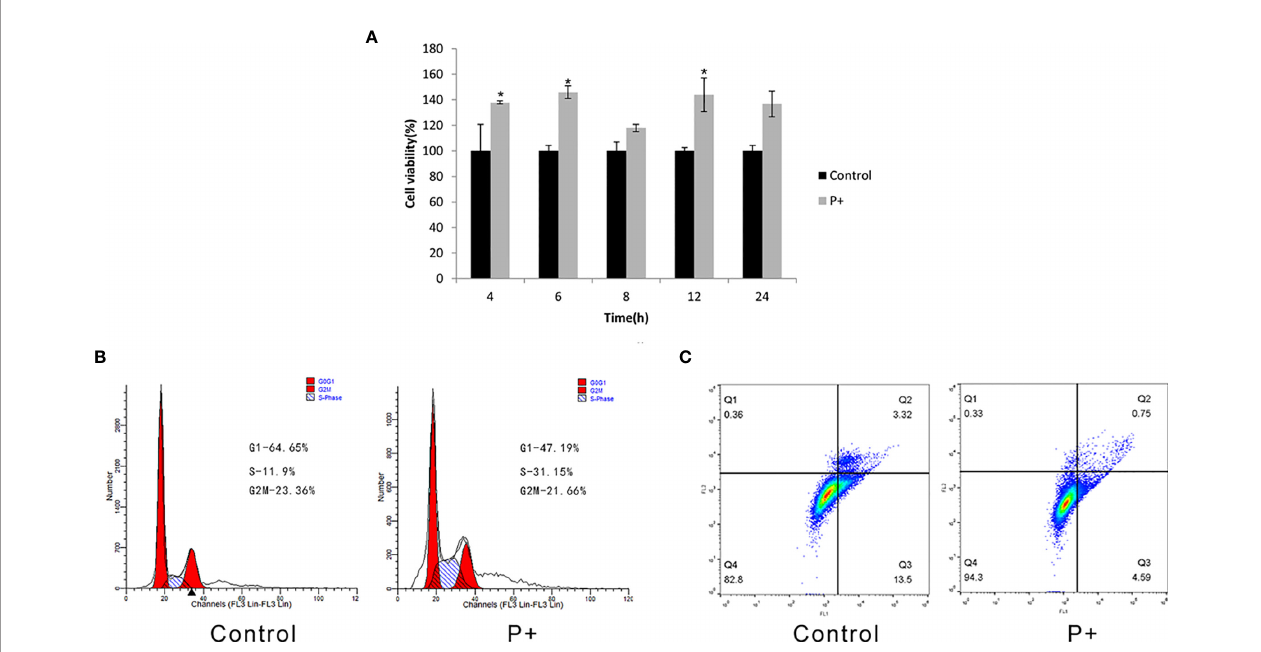
FIGURE 1 | Effect of coinfection of periodontitis-associated bacteria on biological behavior of HSC-3 cells. (A) The cell viability assays of HSC-3. *p < 0.05. (B) The cell cycle analysis and the speci fi c percentage of G1, S, and G2/M phase cell populations. (C) Apoptosis